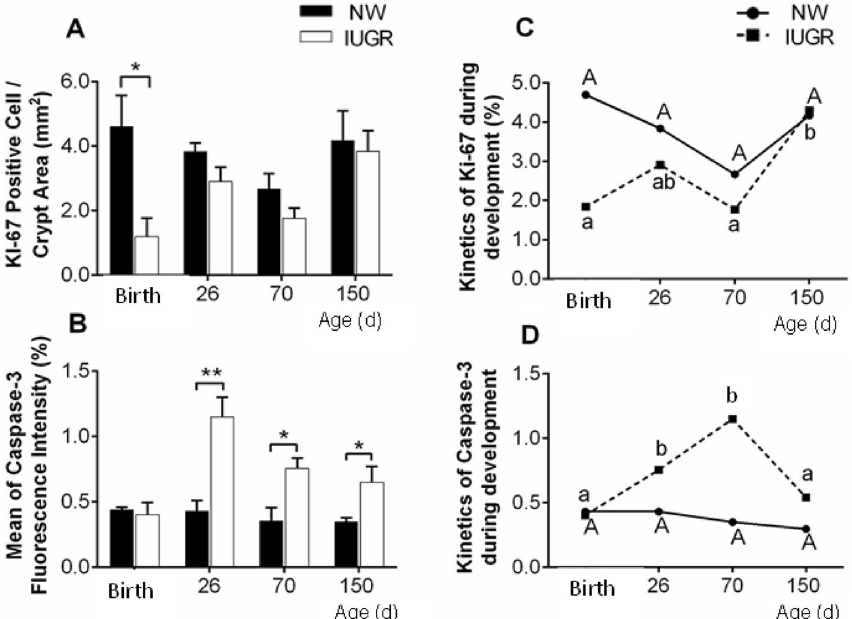
Figure 3. Characterization of Ki-67 and Caspase-3 expressions in the duodenum of intrauterine growth restricted (IUGR) and normal (NW) birth weight male littermate pigs. ( A ) Number of Ki-67 positive cells per area of epithelium of intestinal glands (density). Cellular proliferation was higher in NW piglets at birth, but remained similar between the experimental groups throughout the production phases. ( B ) Mean percentage of Caspase-3 fluorescence cells in the duodenal villi. IUGR pigs presented higher apoptosis after weaning, which remained higher until 150 days of age. ( C ) The pattern of cell proliferation overtime (from birth to 150 days of age) in NW pigs remained relatively constant throughout postnatal development. On the other hand, in IUGR pigs, cell proliferation significantly increased from 70 to 150 days of age ( D ). Regarding the pattern of apoptosis overtime, mean percentage of Caspase-3 fluorescence in the duodenal villi remained constant in the NW animals, but it increased drastically until 70 days in the IUGR pigs. Superscript a, b: LS means differ statistically between groups (**P < 0.01 and *P < 0.05). Error bars represent standard errors of the